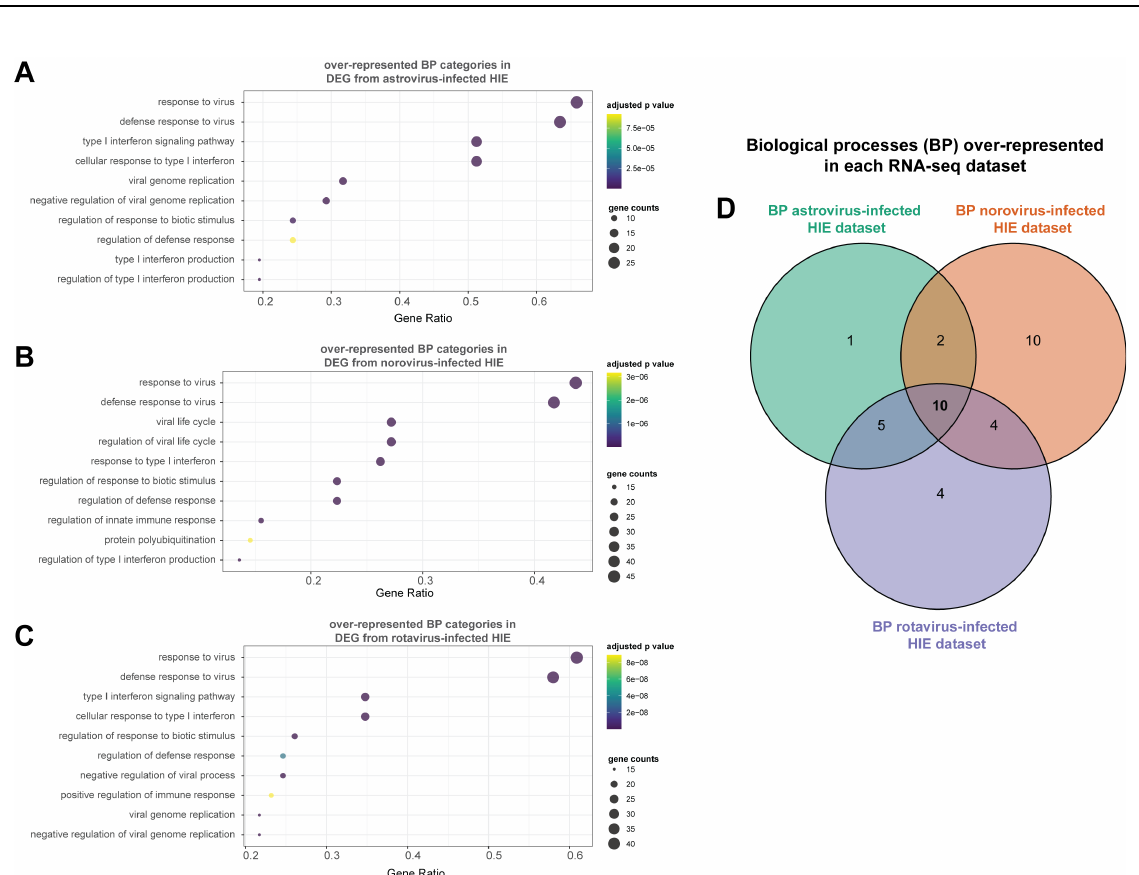
Figure 5. Gene Ontology (GO) over-representation analysis showed that the top over-represented biological processes (BP) for all datasets were associated with defense response to virus and type I IFN responses. Gene ontology (GO) analysis was performed on the list of DEG identified for each independently analyzed dataset to identify over-represented biological processes (BP). The top 10 over-represented BP categories are shown for each dataset as well as the number of genes contributing to the over-representation of each BP. Astrovirus-infected duodenal HIE ( A ), norovirus-infected ileal HIE ( B ), and rotavirus-infected jejunal HIE ( C ) are shown. An adjusted p -value cutoff of 0.001 was used to determine significantly over-represented BP. Shared and unique over-represented BP categories across all datasets were determined from the list of over-represented BP categories obtained for each dataset ( D ). Over-represented BP categories were identified with the package clusterProfiler in R. Table 3. Summary of Gene Ontology (GO) over-representation analysis. Over-representation analysis of biological pro- cesses (BP) was performed with the package ClusterProfiler in R on three published datasets of virus infected HIEs. An